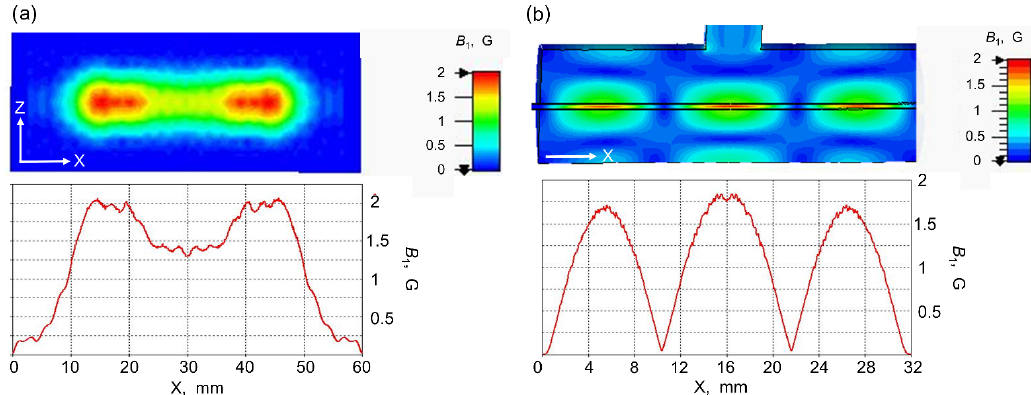
Figure 4. Comparison of field distribution of open resonator with cylindrical resonator. (a) Calculated B 1 field distribution at the plain mirror surface of the Fabry–Pérot resonator in presence of an aqueous layer of 80µm for the TEM 00 mode; (b) B 1 distribution along the 0.5mm ID quartz capillary with water along the TE 013 cylindrical cavity. The B 1 value is calculated for an input mw power of 0.5W.